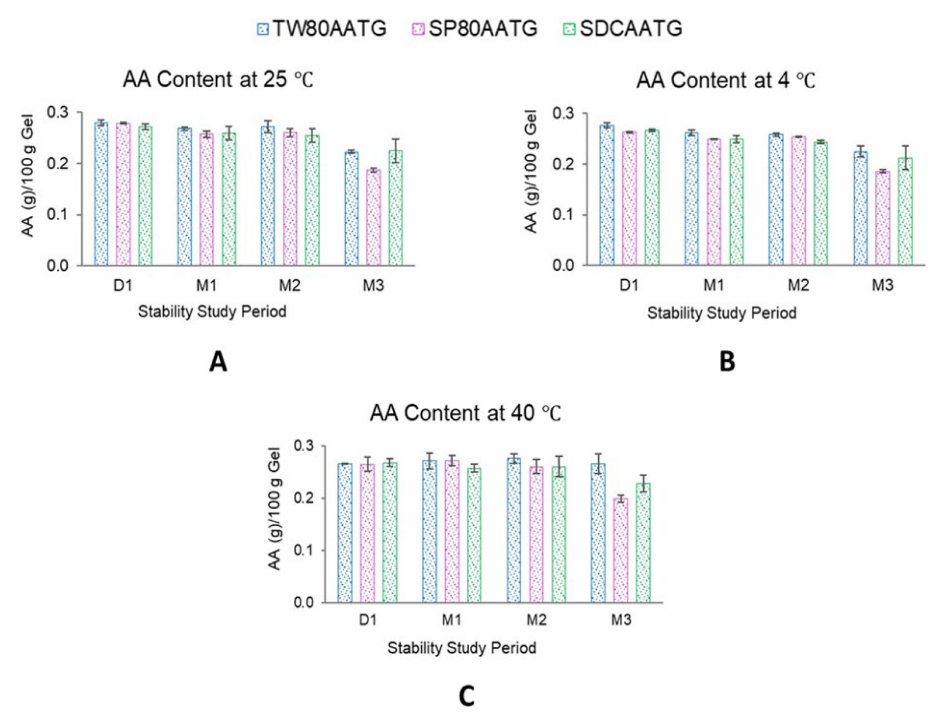
Figure 5. AA content of AATGs at different storage temperatures. ( A ) AA content at 25 ◦ C, ( B ) AA content at 4 ◦ C and ( C ) AA content at 40 ◦ C. Each value represents mean ± SD with n =